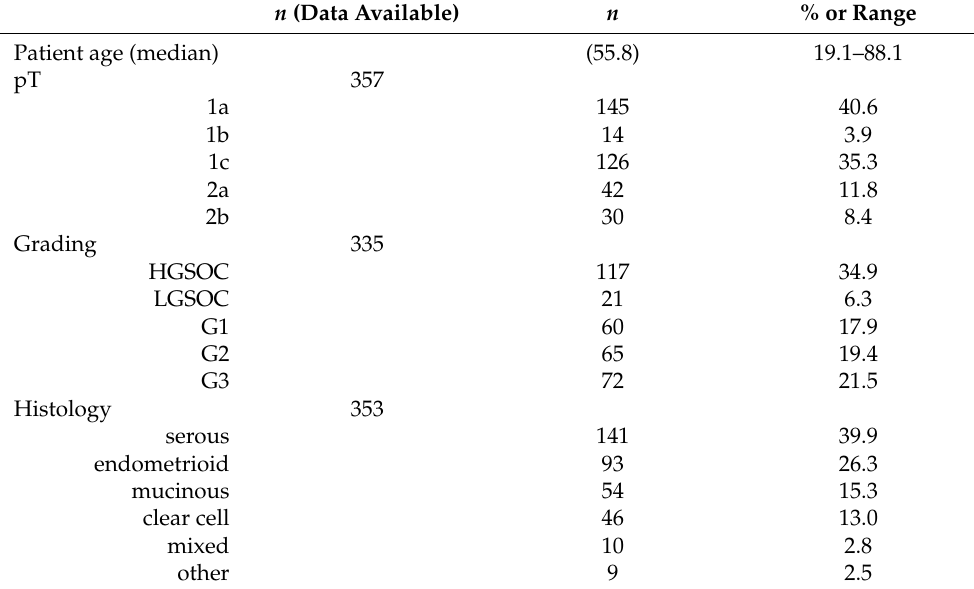
Table 1. Patient